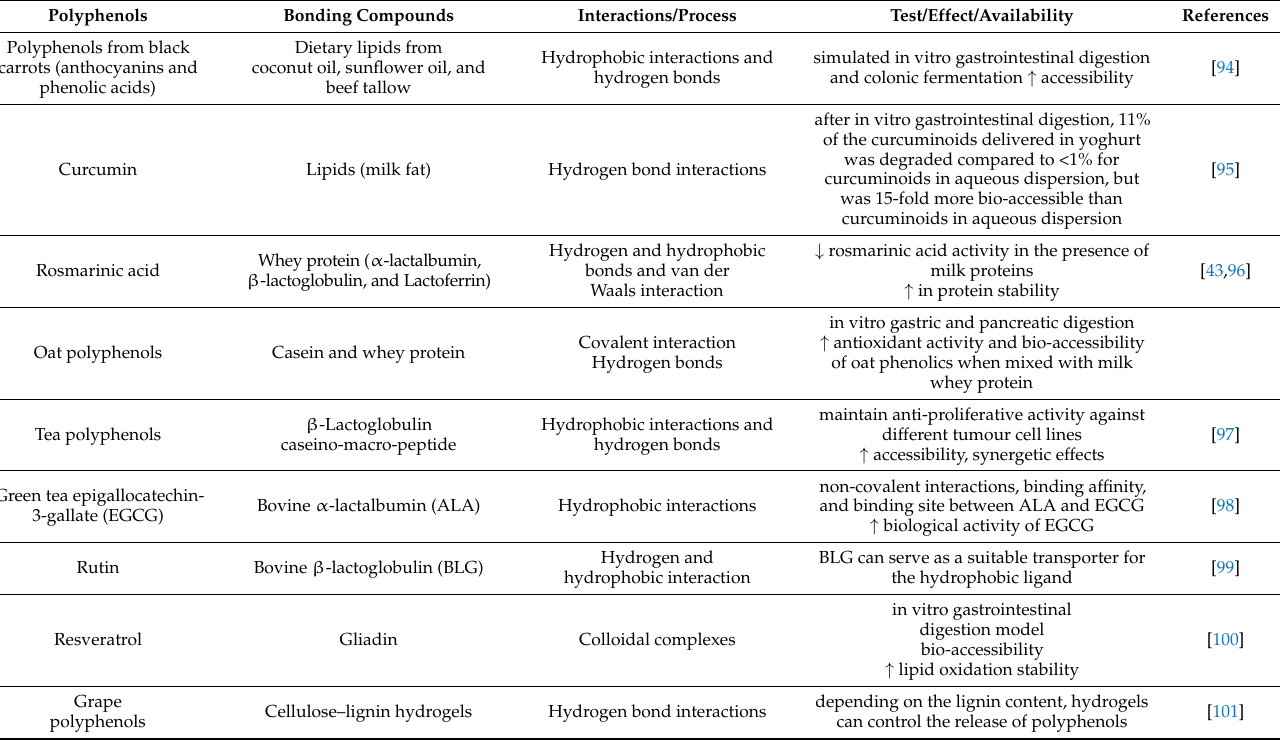
Table 2. Polyphenols bound with different compounds and their